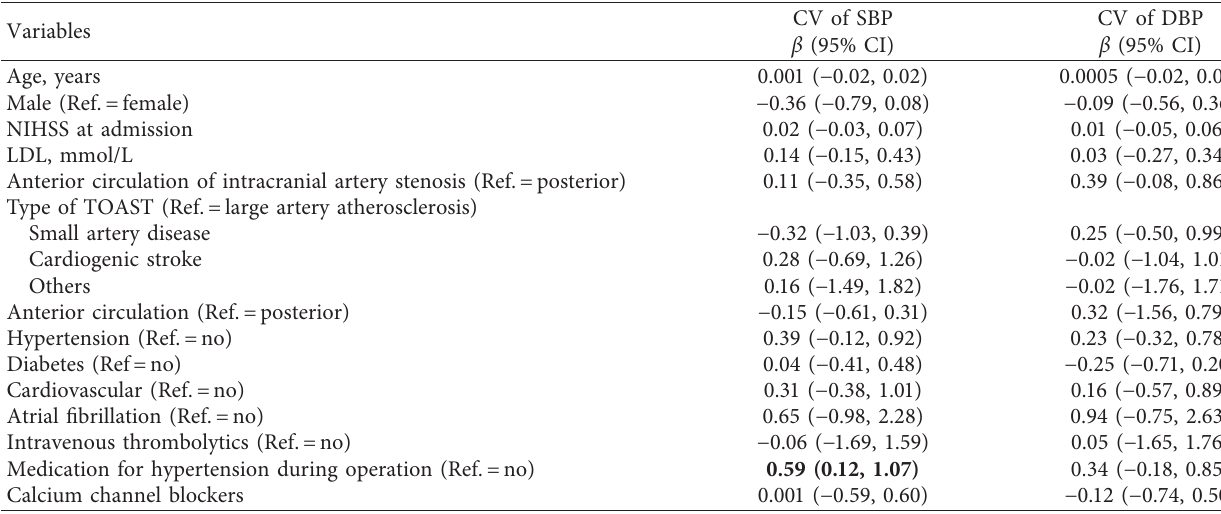
Table 3: Univariate analysis for effectors 1 of coefficient of variance (CV) of BP in patients receiving angiography examination 3 days or more after ( ≥ 3 days) disease onset.